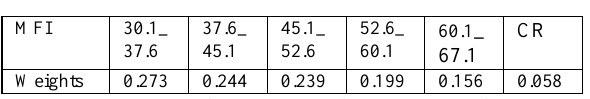
Table 11. Weights of group FAHP for subclasses of MFI Also, results of using fuzzy Large membership function for some layers are shown in Figures 8 and 9.